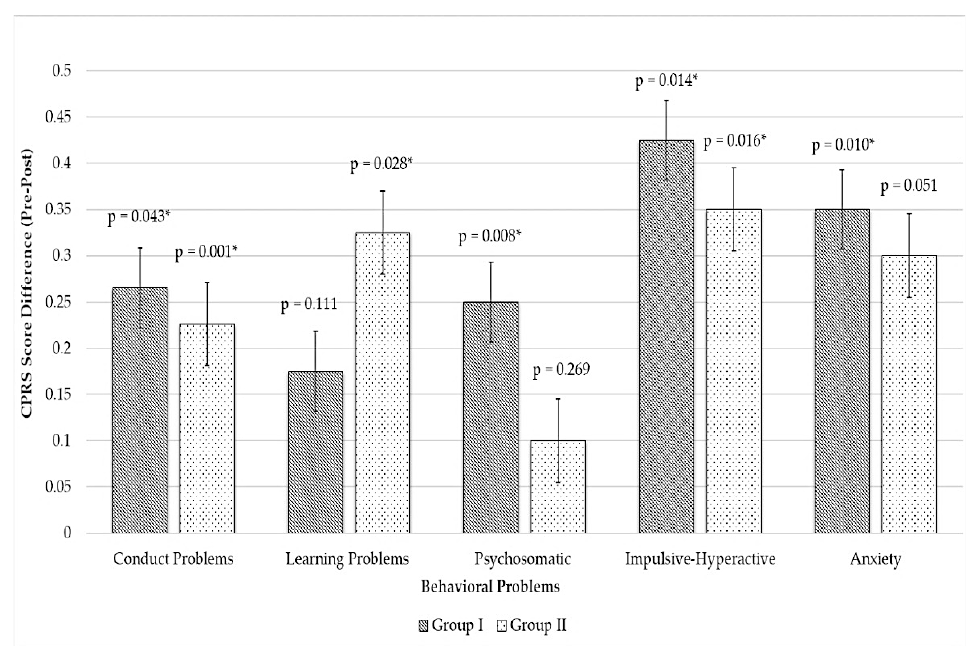
Figure 2. Parents’ rating of behavioral improvement (pretest–posttest) among children in the inflat- able group (group 1) and manual group (group II). Data with * indicate a statistically significance. Table 1. The five subscales of Conne r’s Parent Rating Scale -48 score of groups I and II. Pretest Posttest Subscales Group N Mean Difference p (Mean ± SD) (Mean ± SD) Conduct problems